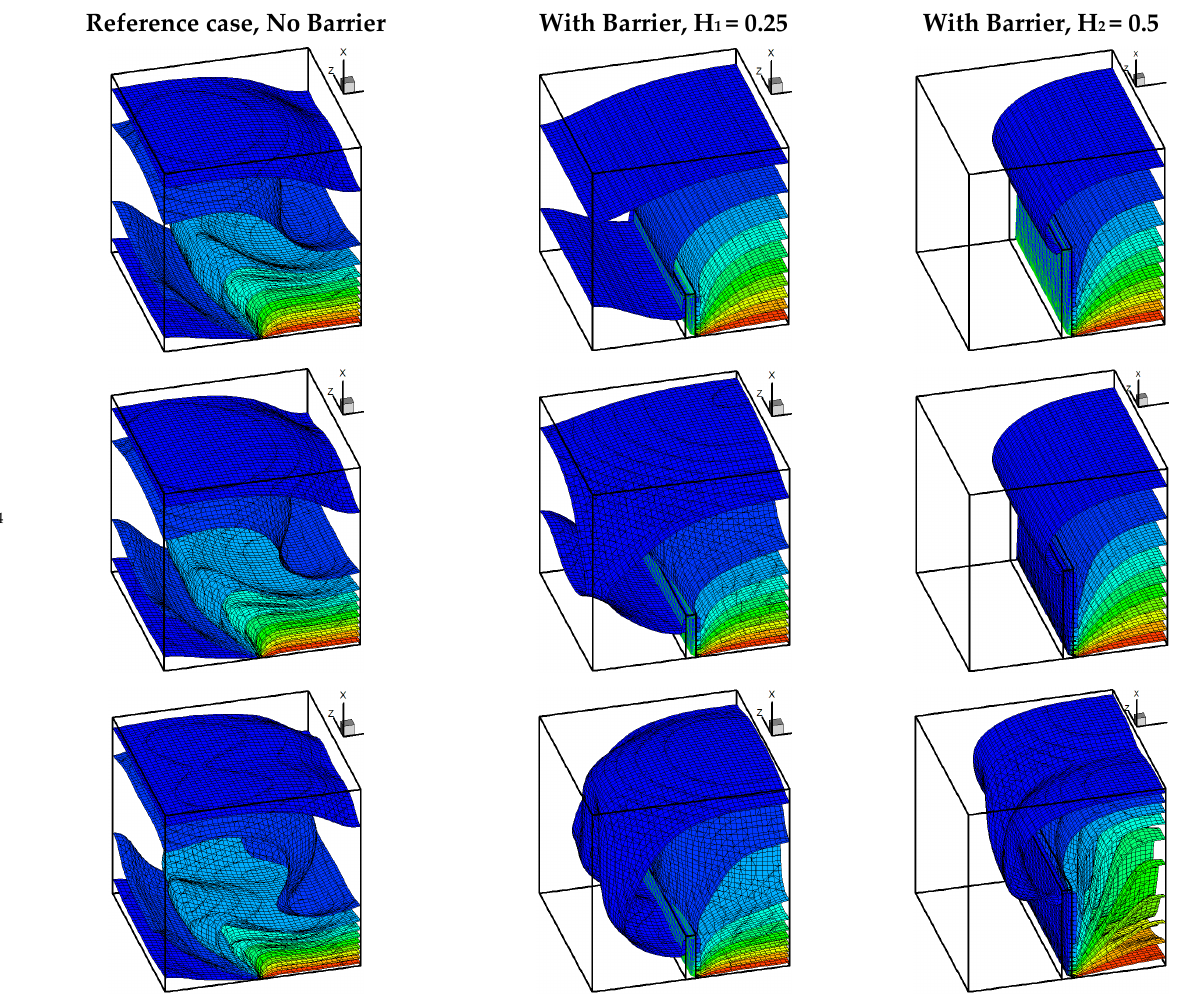
Figure 9. Contaminant iso-surfaces of concentration for different Ra, effect of two barriers’ heights for N = −0.2. Figure 10 shows the effect of Rayleigh numbers on temperature iso-surfaces. In the absence of a barrier, the thermal convective regime appears from the value of Ra = 10 4 , while increasing the Rayleigh number increases the thermal gradient. In the presence of barrier height 1, the convective regime appears from Rayleigh 1.5 × 10 4 , while for barrier height 2, the convective regime is observed for Ra = 5 × 10 4